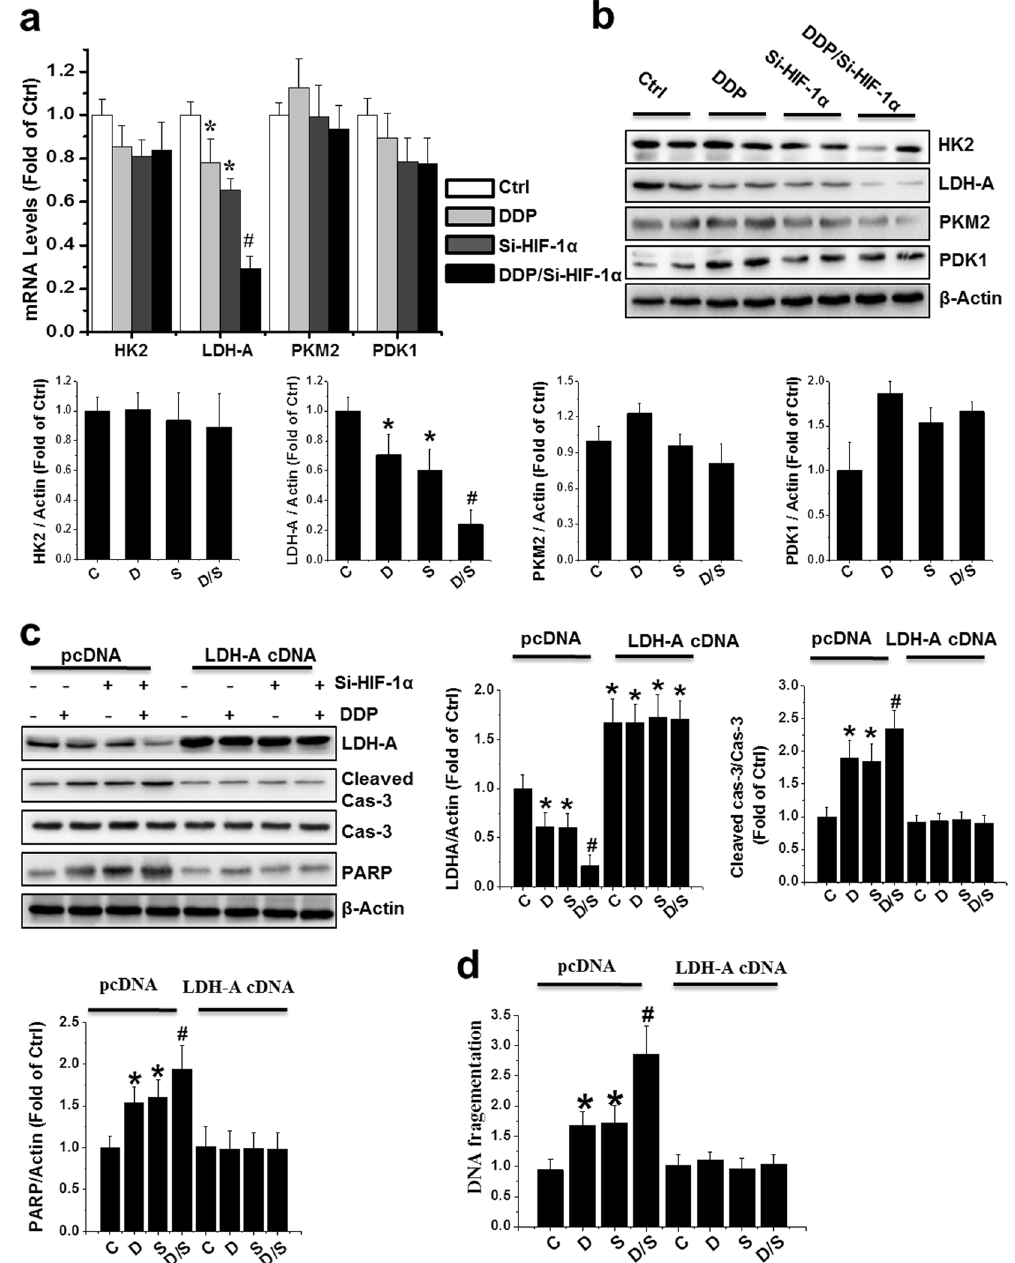
Figure 6. LDH-A overexpression blocked apoptosis induced by DDP and/or HIF-1 α siRNA. ( a , b ) mRNA and protein expression of HK2, LDH-A, PKM2 and PDK1 was examined with qRT-PCR ( a ) and western blot ( b ) in PCa xenografts. ( c , d ) PC-3 cells were transfected with a human LDH-A cDNA construct or empty vector (pcDNA) for 48 h. Following 24 h of cDNA treatment, the cells were treated by transient transfection with si- HIF-1 α alone, DDP alone, or both in combination. Cell lysates were subjected to western blot analysis with the indicated antibodies ( c ) and an apoptosis ELISA ( d ). Data were presented as mean ± SD of three independent experiments. * p < 0.05 versus control group; # p < 0.05 versus si-HIF-1 α or DDP group. The original blots are presented in Supplementary Figure